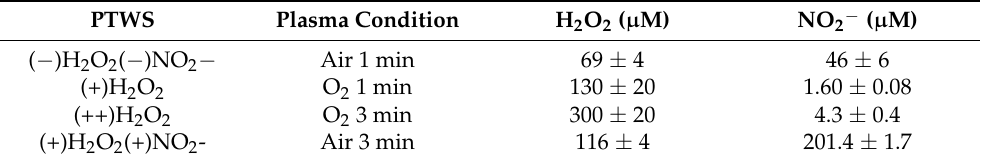
Table 2. Composition of PT-DMEM (DBDs ignited at 13 kV, 6 kHz, 25% DC, 100 ms period), produced with different feeds (0.5 slm) and treatment times (1 or 3 min) for cell culture experiments. PTWS Plasma Condition H 2 O 2 ( µ